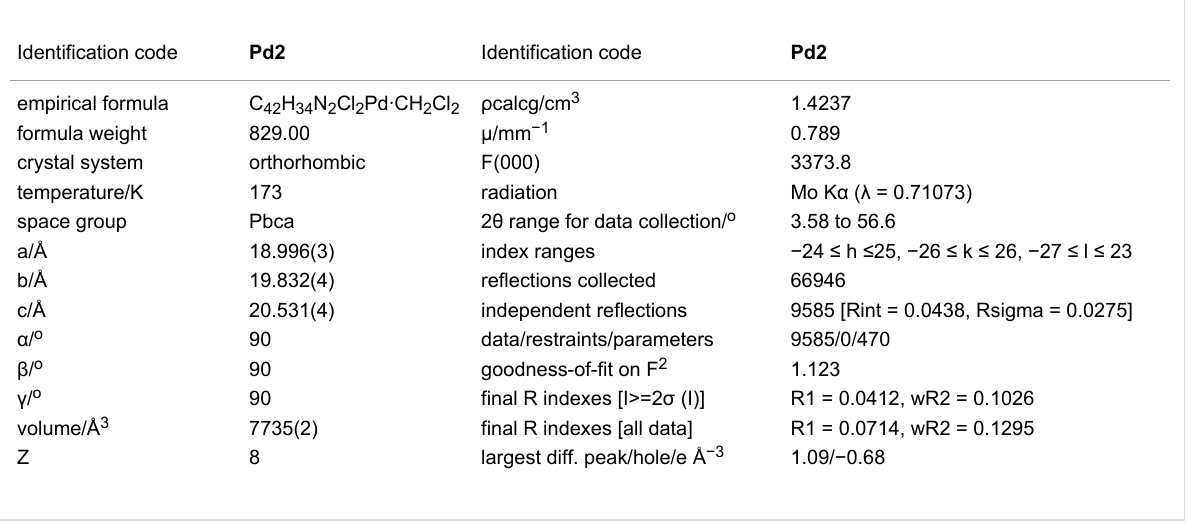
Table 5: Crystal data and structure refinement for Pd2